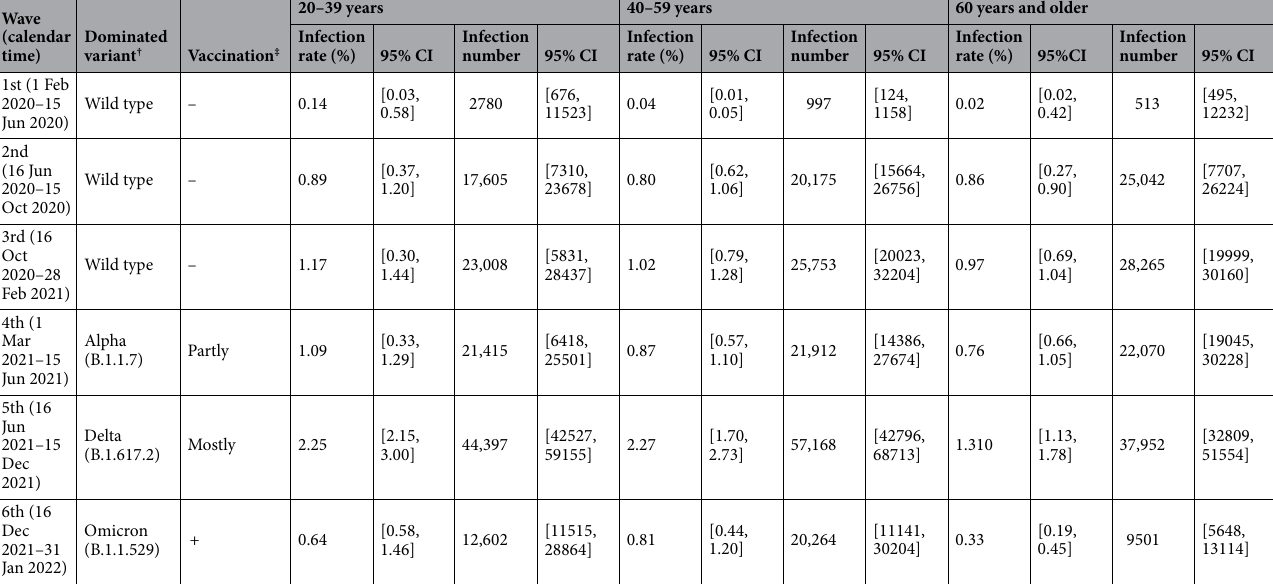
Table 1. Cumulative risk of infection and estimated incidence of COVID-19 in Osaka, Japan, 2020–2022. CI confidence interval (based on bootstrap method). † The variant of concern that occupied the largest